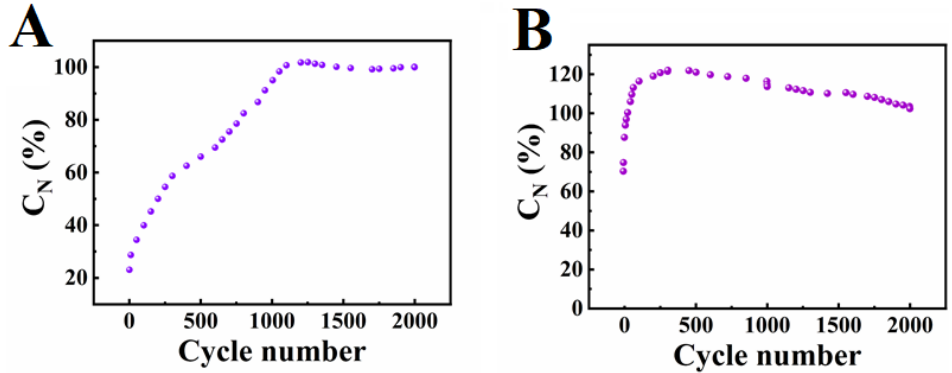
Figure 8. Normalized capacitances (C N ) versus cycle number at a scan rate of 50 mV s − 1 for electrodes prepared by ( A ) Method 1 and ( B ) Method 2, normalized by the capacitance for the 2000th cycle.